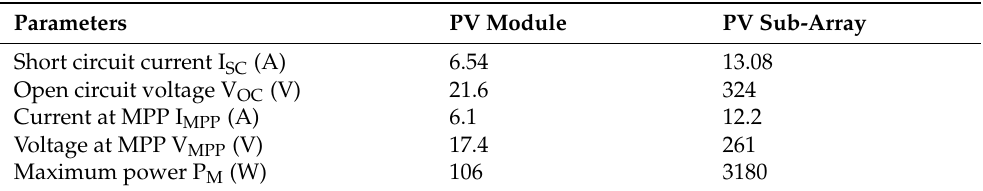
Figure 3. Picture of the GCPVS laboratory at CDER. Table 1. Main electrical specification of PV Module (Isofoton I106-12) and PV sub-array at standard test condition (STC).